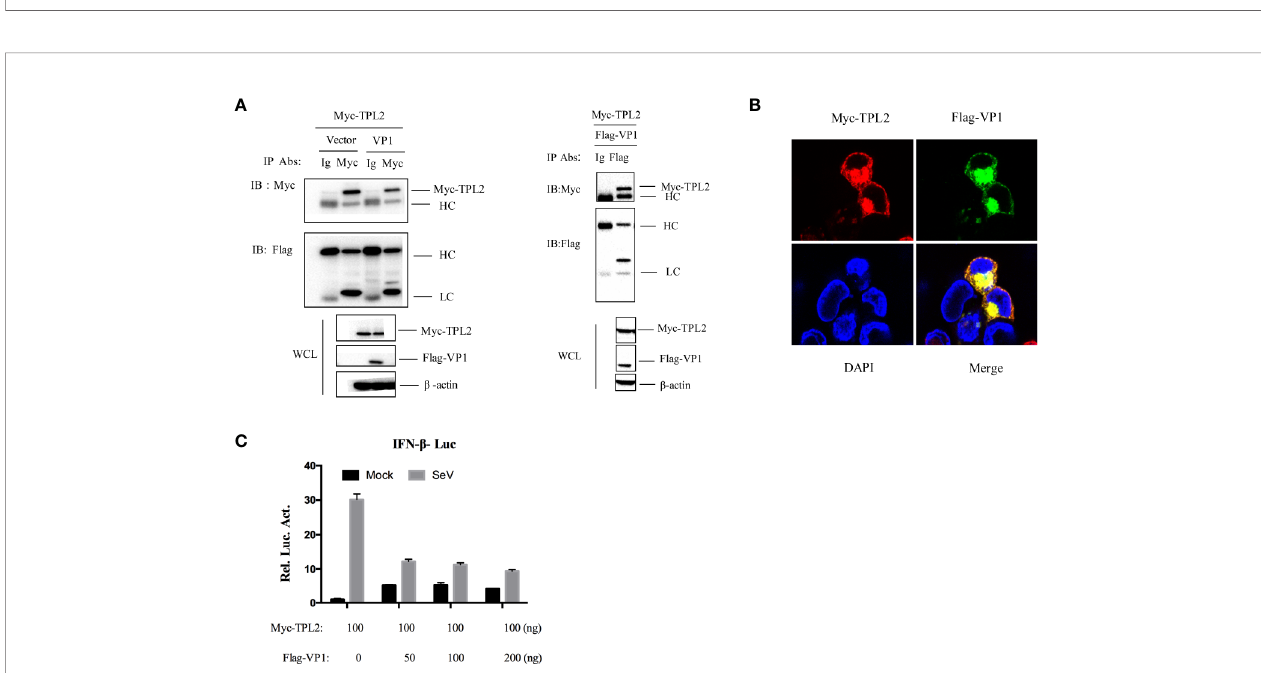
FIGURE 3 | VP1 interacted with TPL2. (A) HEK293T cells were transfected with plasmids expressing FMDV VP1 (8 m g) and TPL2 (8 m g); cell lysates were incubated with anti-Myc and control IgG antibodies. Co-immunoprecipitation complexes were detected with anti-Flag and anti-Myc. (B) HEK293T cells were transfected with plasmids expressing Myc-TPL2 (1 m g) and Flag-VP1 (1 m g) and subjected to immunohistochemical staining; as shown Myc-TPL2 (red), Flag-VP1 (green), and cellular nuclei were stained blue with DAPI. (C) HEK293T cells were transfected with expression plasmids as indicated and then mock-infected or infected with SeV.